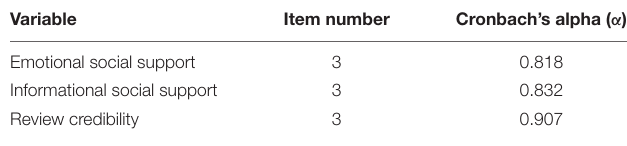
TABLE 3 | Reliability analysis